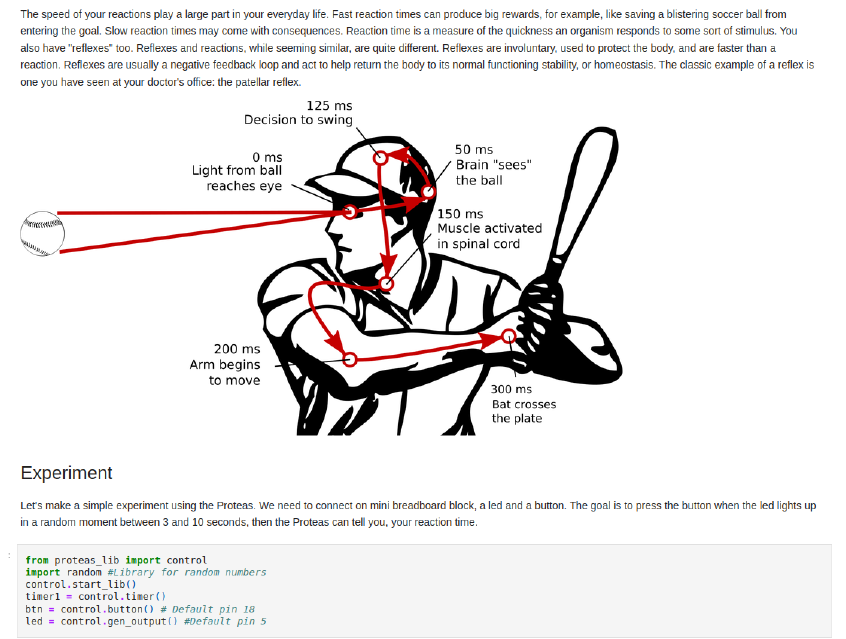
Figure 6. Notebook coding mode